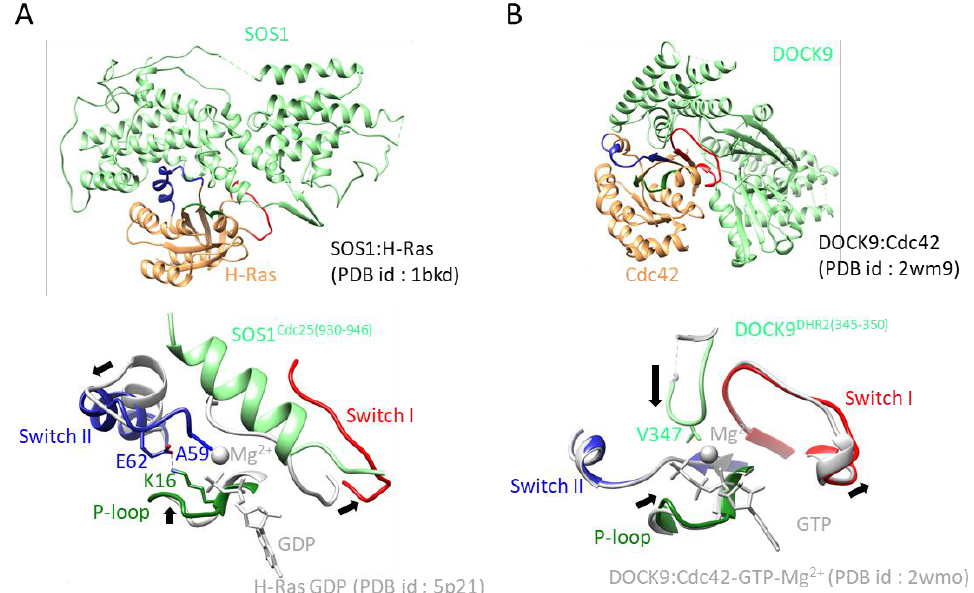
Figure 3. GEF:GTPase structures and their exchange mechanisms: ( A ) Upper: overall structure of the SOS1:H-Ras complex. SOS1 and H-Ras are colored green and orange, respectively. The P-loop, switch I, and switch II are colored green, red, and blue, respectively. Lower: Close up view of the active site of the SOS1:H-Ras complex: structural rearrangement is indicated by a black arrow. Key residues for exerting GEF activity are shown as stick models. The color scheme of the complex follows that of upper figure. The structure of the GDP-bound form of H-Ras, including GDP and Mg 2 + , is overlaid and colored in gray. ( B ) Upper: overall structure of the Dock9:Cdc42 complex. The structure of the GDP-bound form of Cdc42, including GTP and Mg 2 + , is overlaid. Lower: Close up view of the active site of the Dock9:Cdc42 complex. The color scheme and other descriptions follow those of Figure 1B.